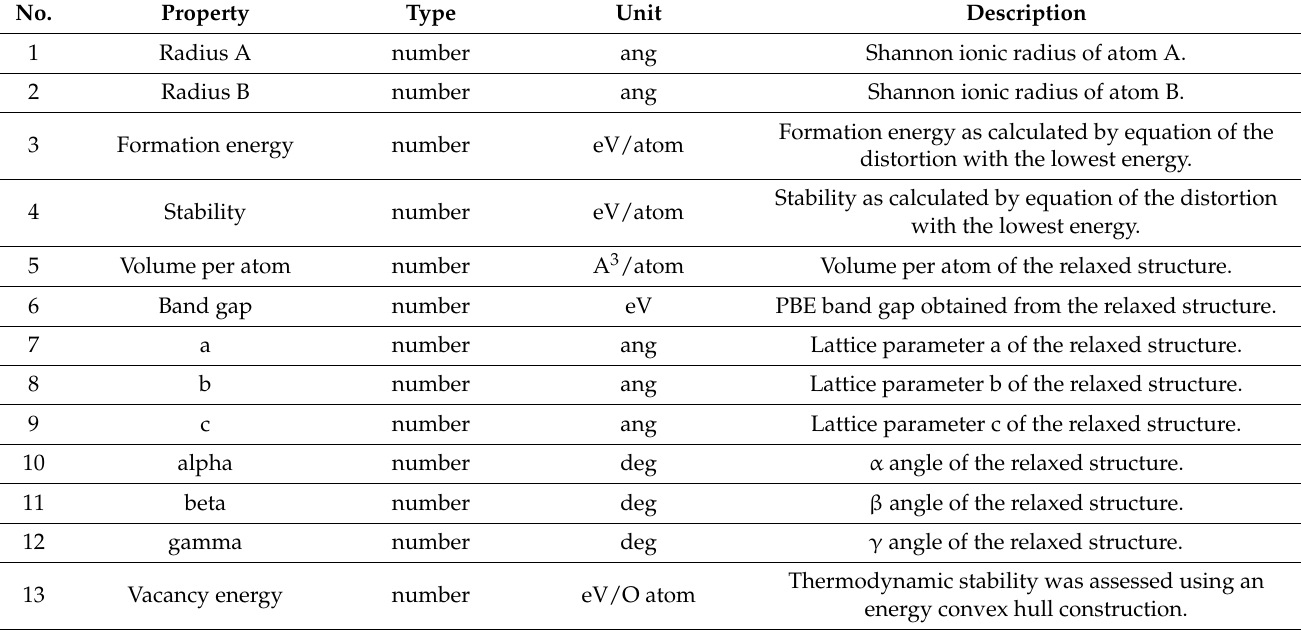
Table 1. Characteristic performance parameters of perovskite data